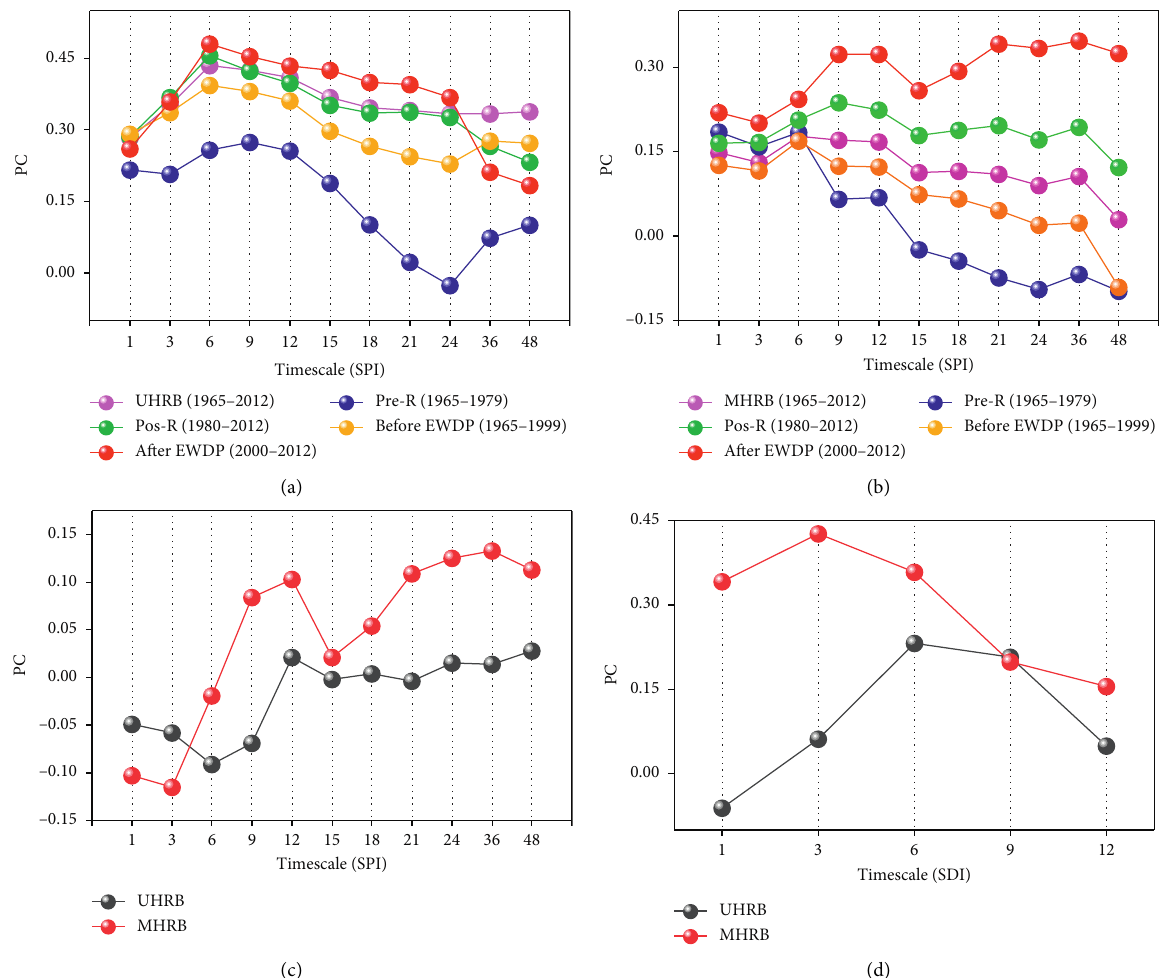
Figure 9: Pearson’s correlation coefficien between SDI-1 and SPI (a, b) for different timescales at different periods, and VCI (c, d) with different timescales of SPI and SDI in the UHRB (Ylx) and in the MHRB